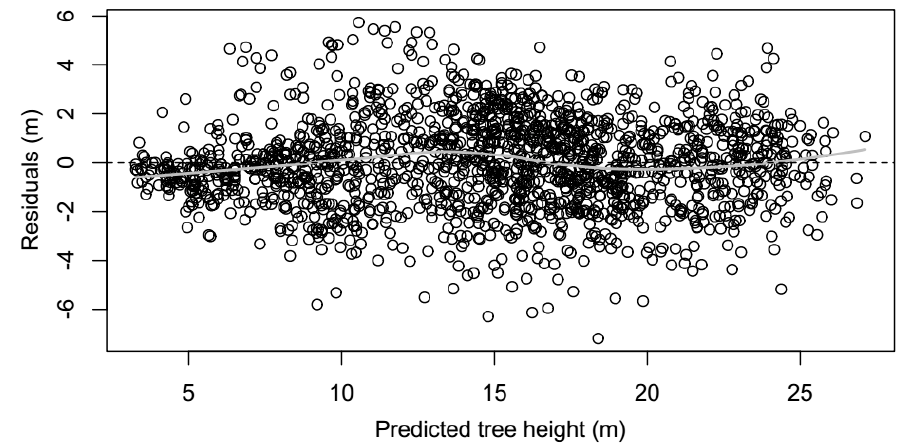
Figure 3. Residual plot of the fold-6th base models. The solid gray line is from loess regression.